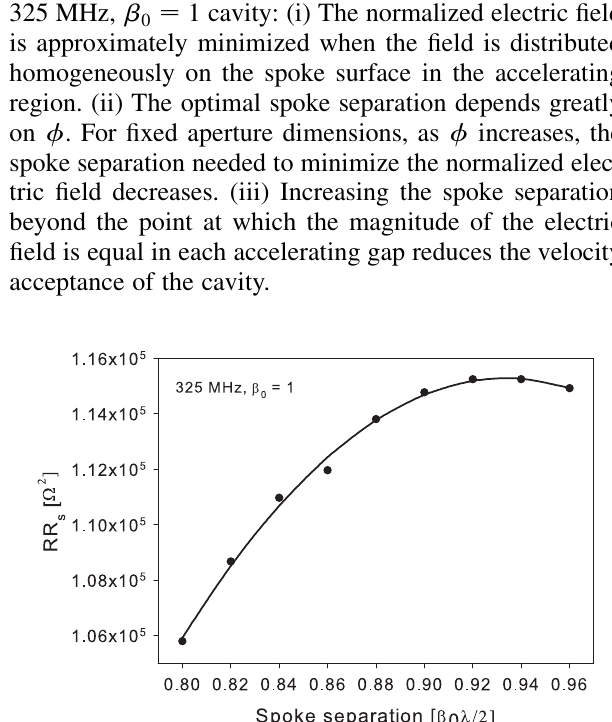
FIG. 23. On-axis electric field profiles (at 1 J) for different spoke angle (cid:2) .